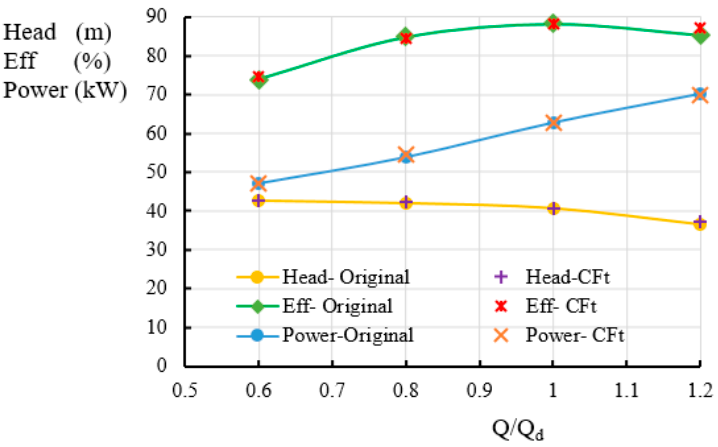
Figure 12. Comparison of Cfturbo built impeller to original model.